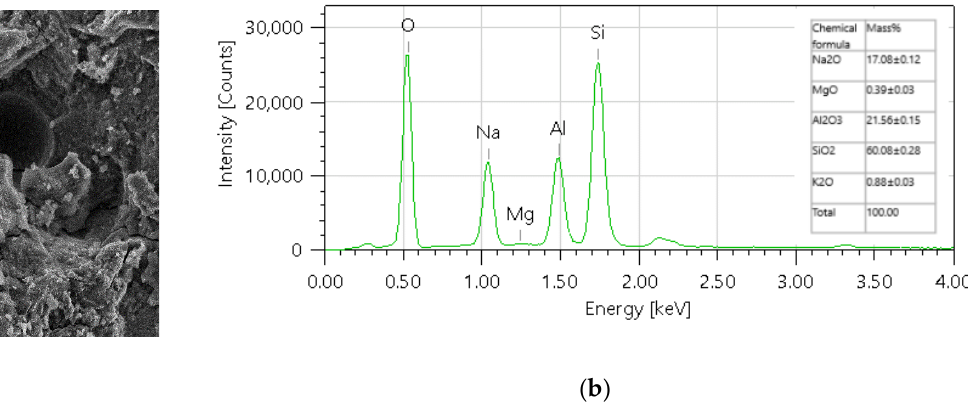
Figure 5. Geopolymer sample: ( a ) SEM image with the point of measurements; and ( b ) results of the EDS analysis.